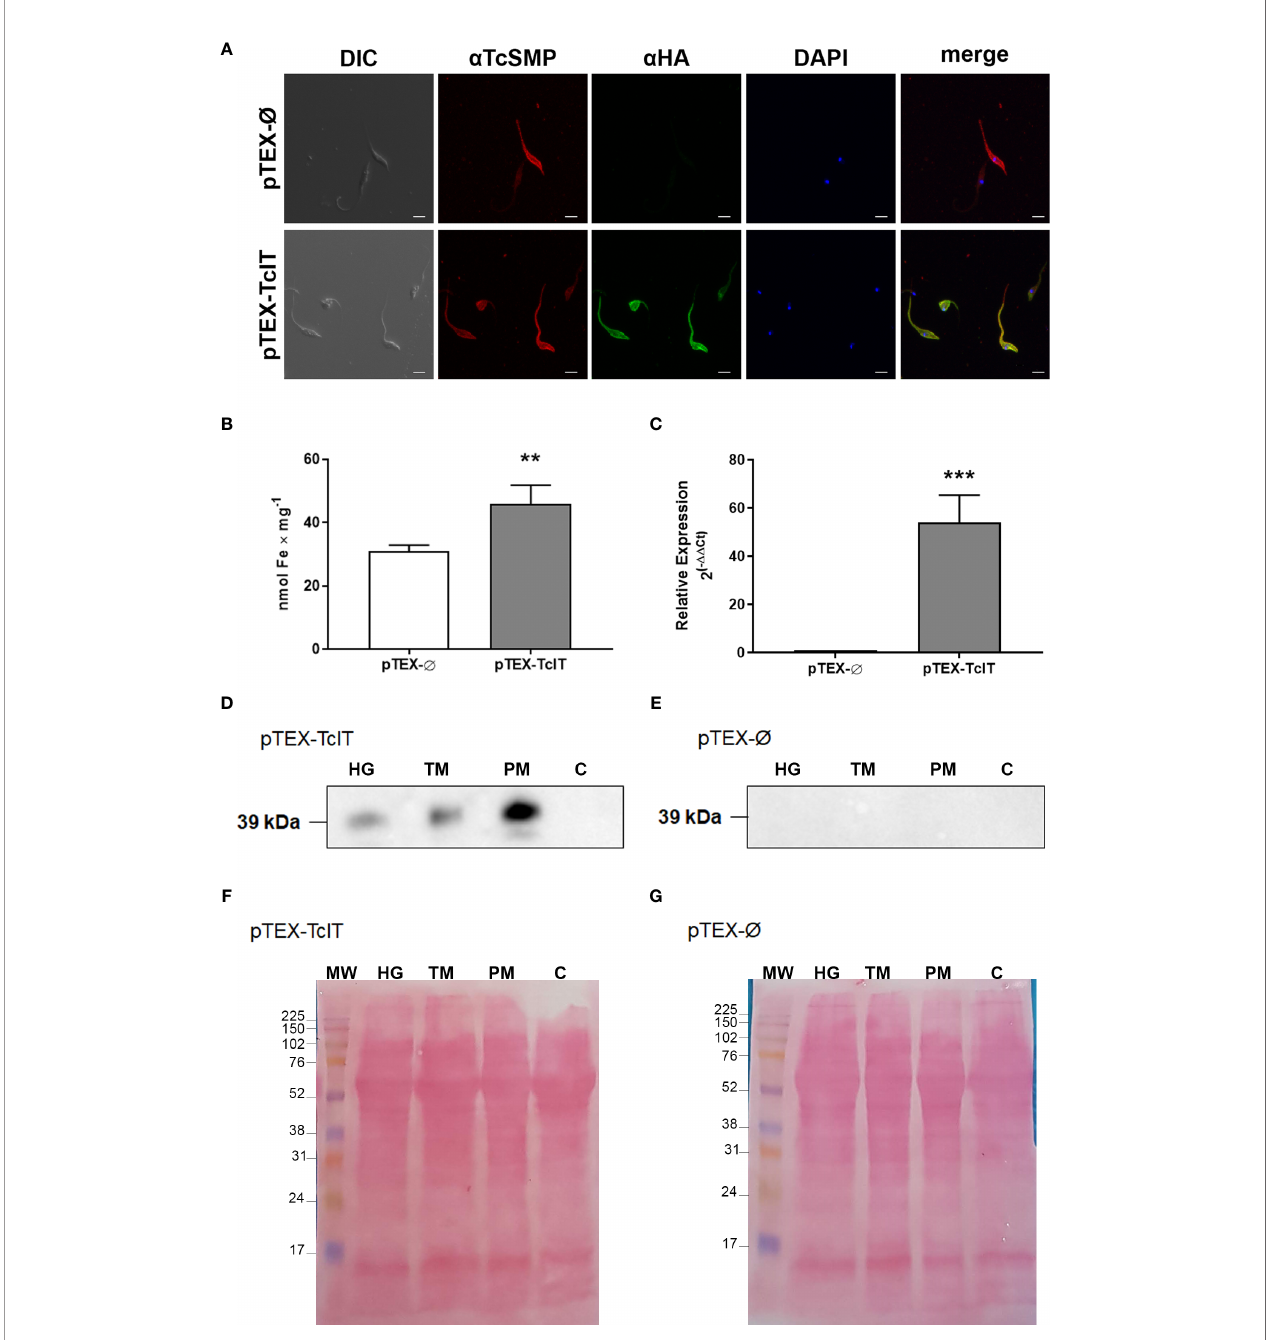
FIGURE 3 | (A) Immuno fl uorescence of epimastigotes shows TcIT expression in plasma membranes. Trypanosoma cruzi epimastigotes were transfected with empty vector (pTEX-Ø) or TcIT tagged with hemagglutinin (pTEX-TcIT). DIC: differential interference contrast microscopy. TcSMP: images using antisera for this surface membrane protein and the secondary anti-mouse-Alexa 546 (red). HA: TcIT expression using anti-HA and secondary anti-rabbit FITC (green). DAPI: nuclei stained with DAPI (blue). In merge, the green fl uorescent staining for TcIT overlaps with the red fl uorescent signal for TcSMP, suggesting the proteins are in the same region of the plasma membrane; ×60 magni fi cation, scale bar 4 m m. (B) Intracellular Fe content is higher in epimastigotes transfected with pTEX-Ø (empty bar) or pTEX-TcIT (gray bar); ** P < 0.01 ( n = 6). (C) Quanti fi cation of the TcIT transcript in T. cruzi epimastigotes. Quantitative PCR was carried out using 100 ng cDNA from mutants pTEX-Ø (empty bar) or pTEX-TcIT (gray bar); *** P < 0.001 ( n = 4). In both cases, using Student ’ s t -test assessed differences between mean values. (D) Representative Western blot using homogenate (HG), total membrane (TM), plasma membrane (PM), and cytosol (C) fractions from pTEX-TcIT epimastigotes, as indicated in the upper part of the image, and the antibody anti-HA. (E) Representative Western blot using HG, TM, PM, and C fractions from pTEX-Ø epimastigotes, as indicated in the upper part of the image, and the antibody anti-HA. The predicted size of TcIT is 39.8 kDa. (F, G) Ponceau red loading controls for representative Western blots of membranes from pTEX-TcIT and pTEX-Ø epimastigotes, as indicated in the upper left